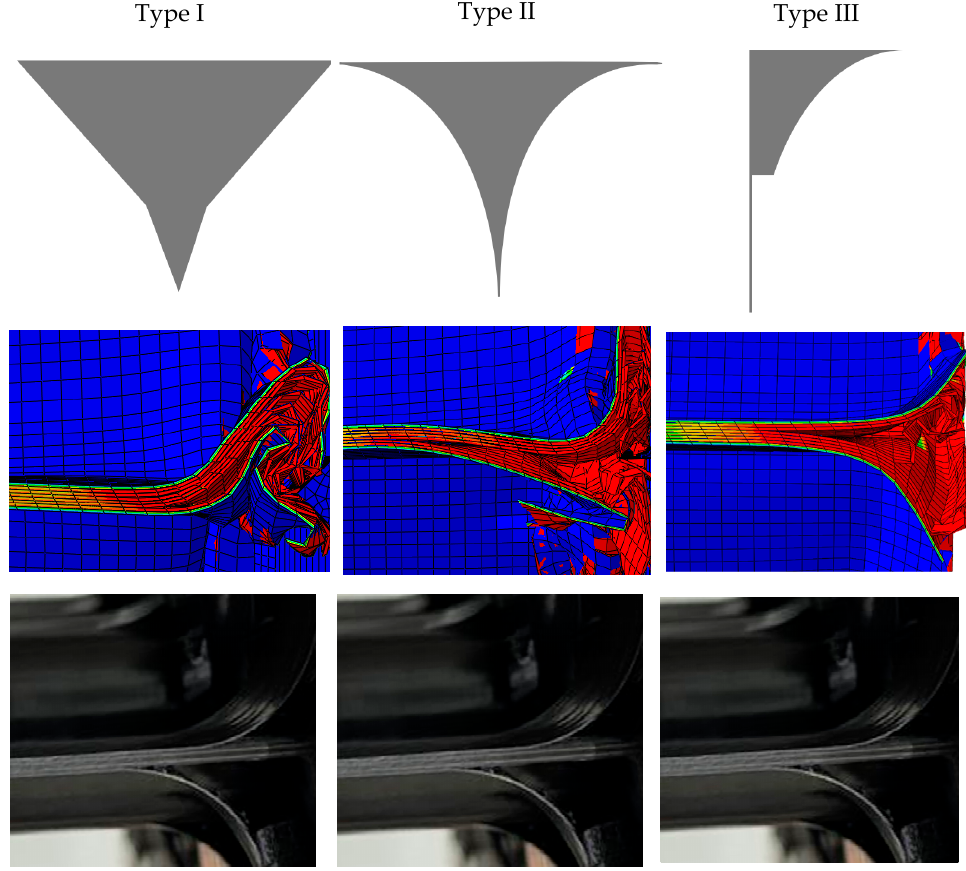
Figure 14. Evaluation of the artificial plug-initiator geometry and the corresponding simulation results compared with the experimentally observed failure modes.